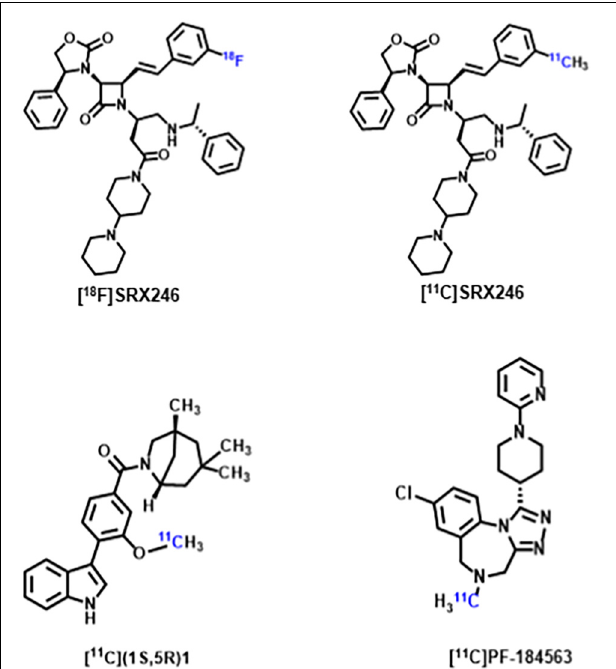
FIGURE 2 | Chemical structure of V1aR targeting